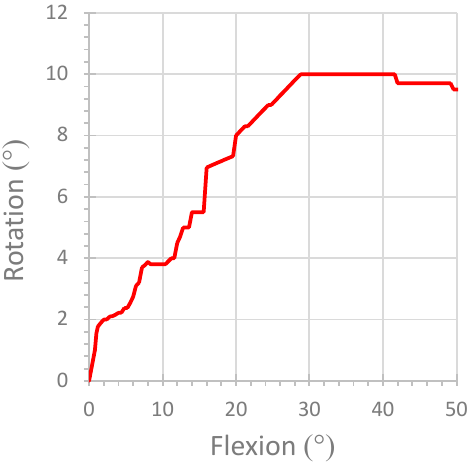
Figure 12. A Graph of Rotation Against Flexion at the position 50°.